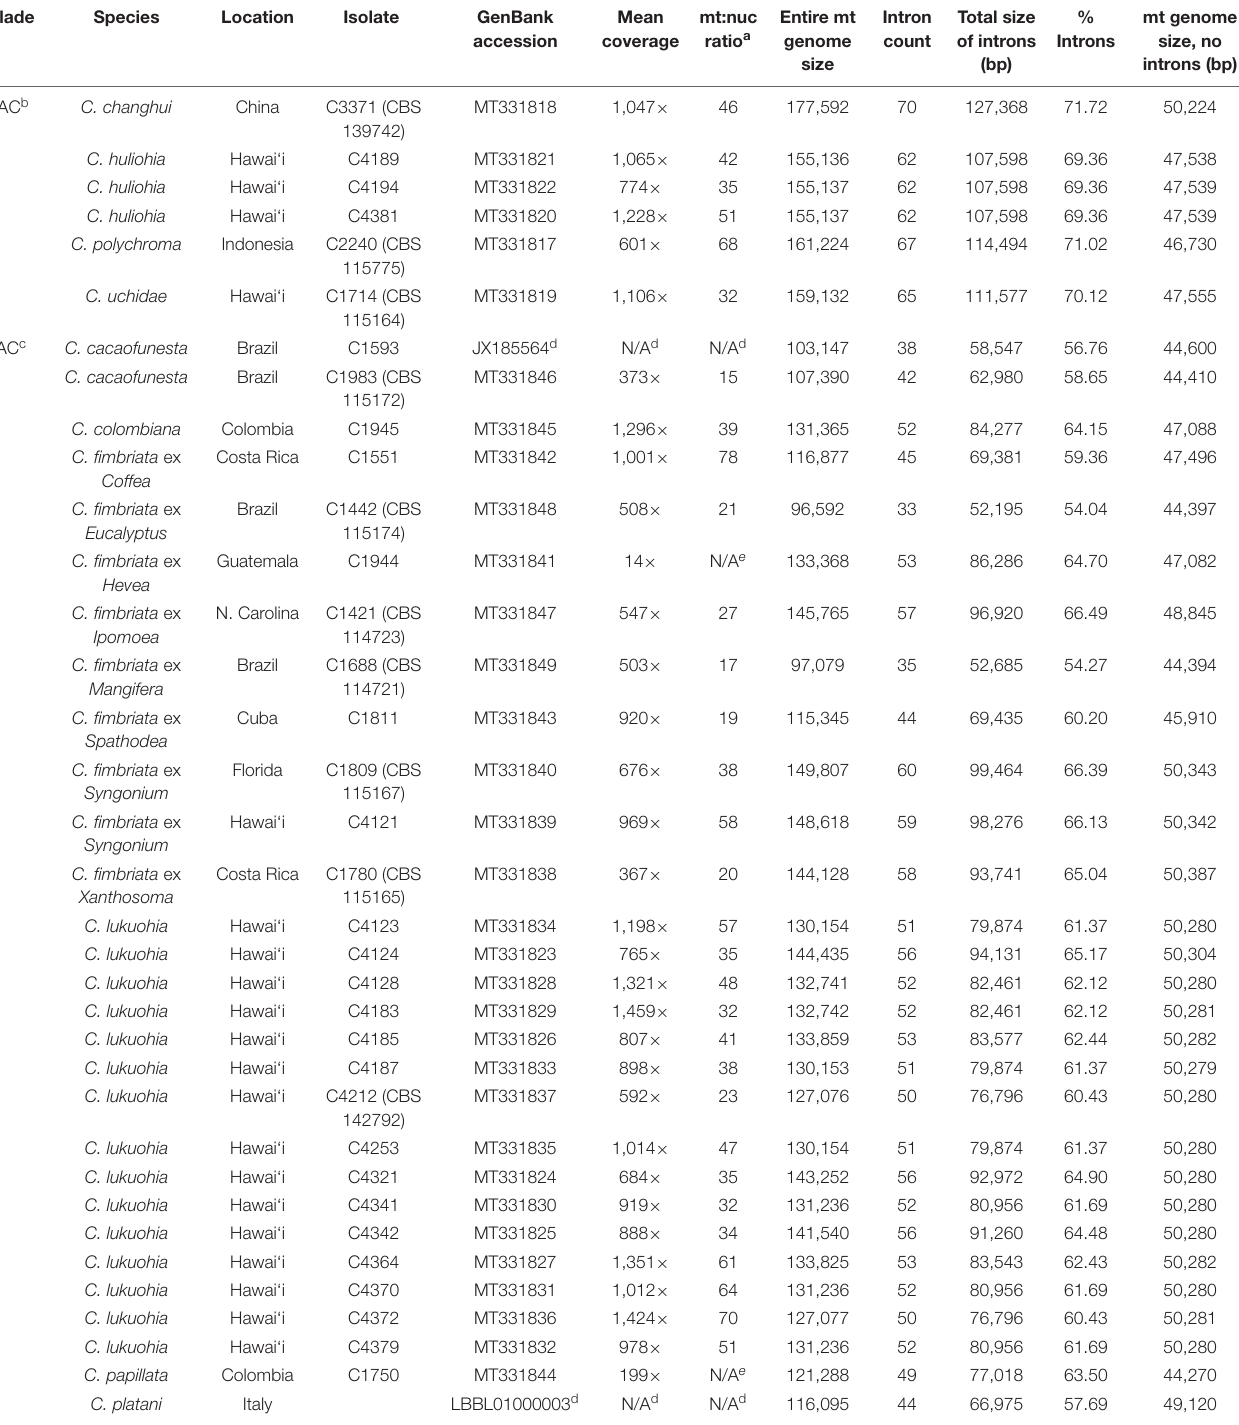
TABLE 1 | Mitogenome size, introns, and estimated ratio of mitochondrial to nuclear genome coverage of Ceratocystis isolates. Clade Species Location